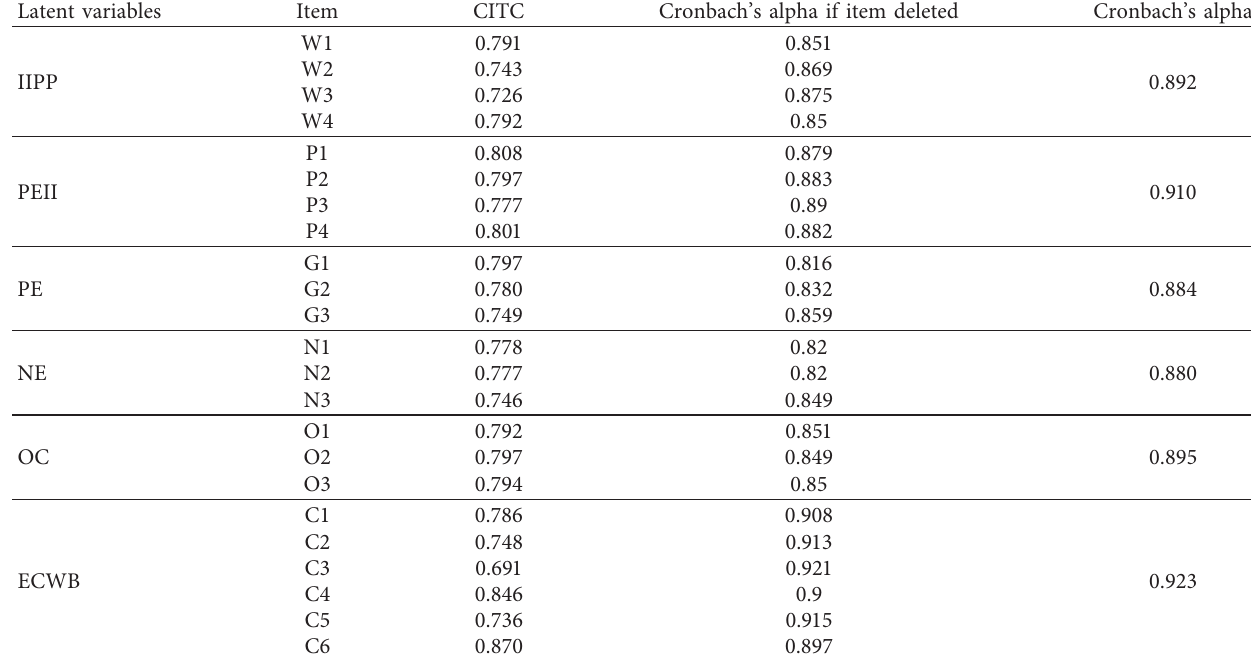
Table 3: Reliability of each variable.